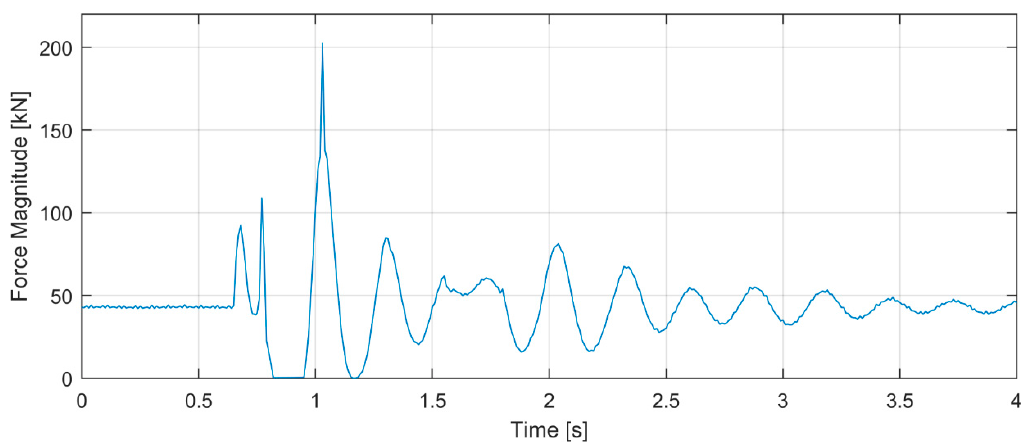
Figure 11. Magnitude of the force on the FL wheel hub provided by the updated numerical model.